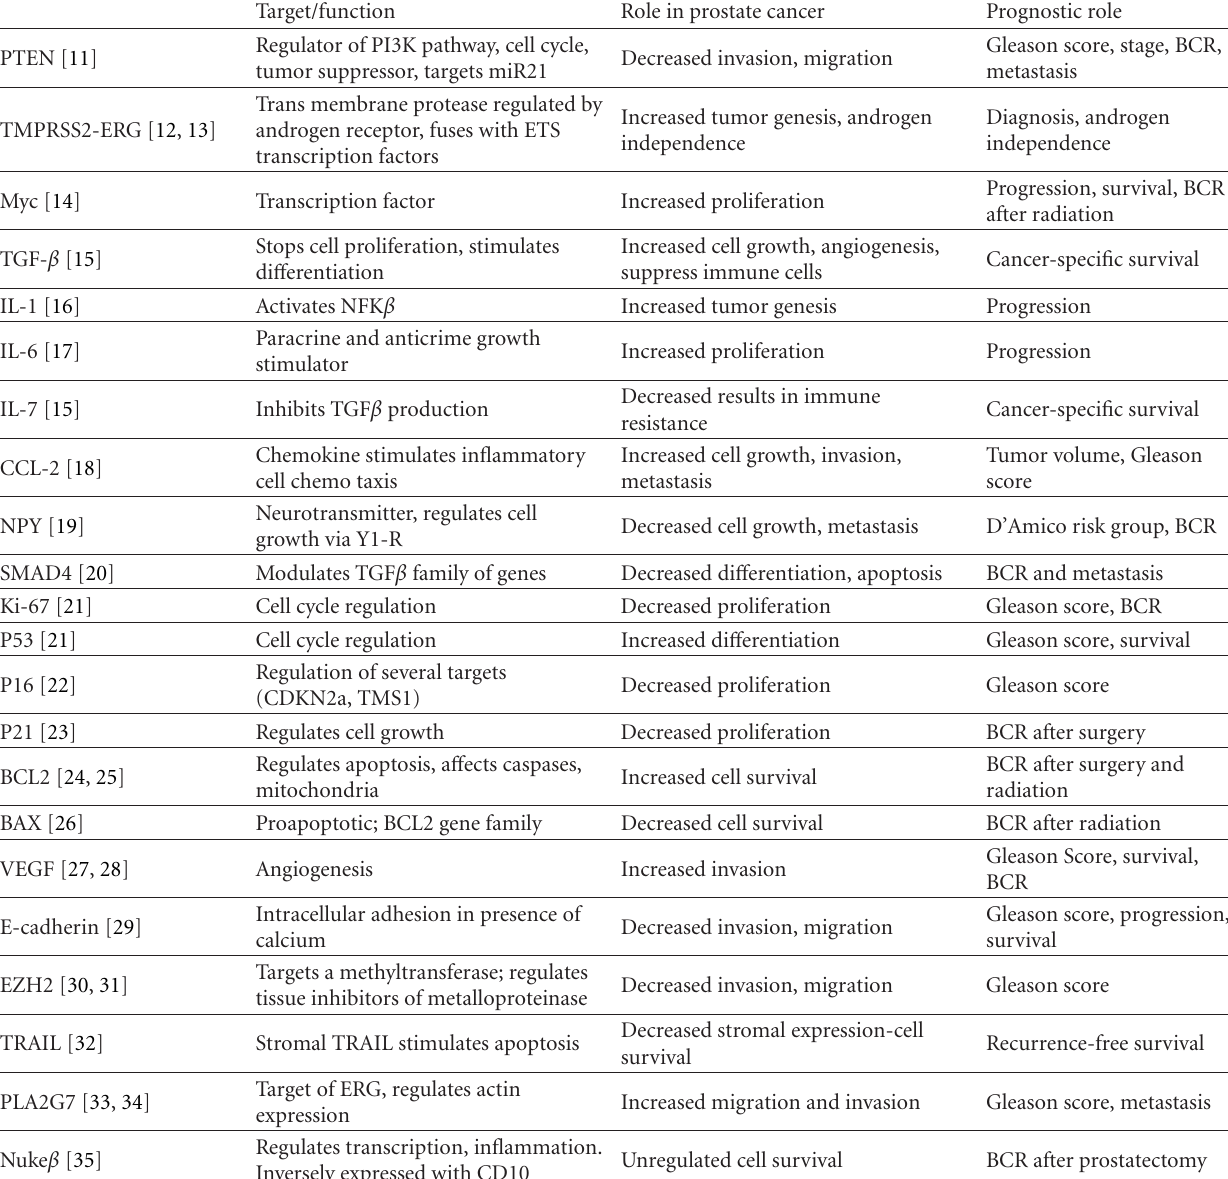
Table 1: Di ff erentially expressed genes reported to be prognostic for prostate